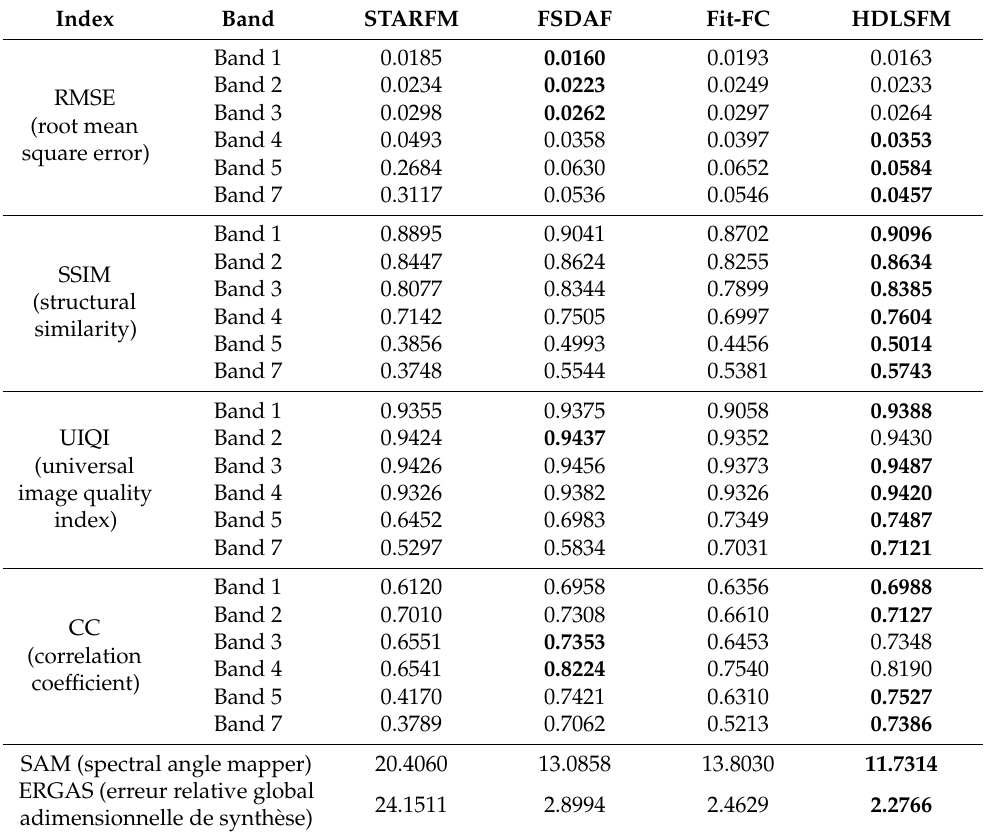
Figure 6. Prediction results of different STF methods for the LGC site. Table 3. Prediction results for the sub area of the LGC site. Bold values indicate best results.